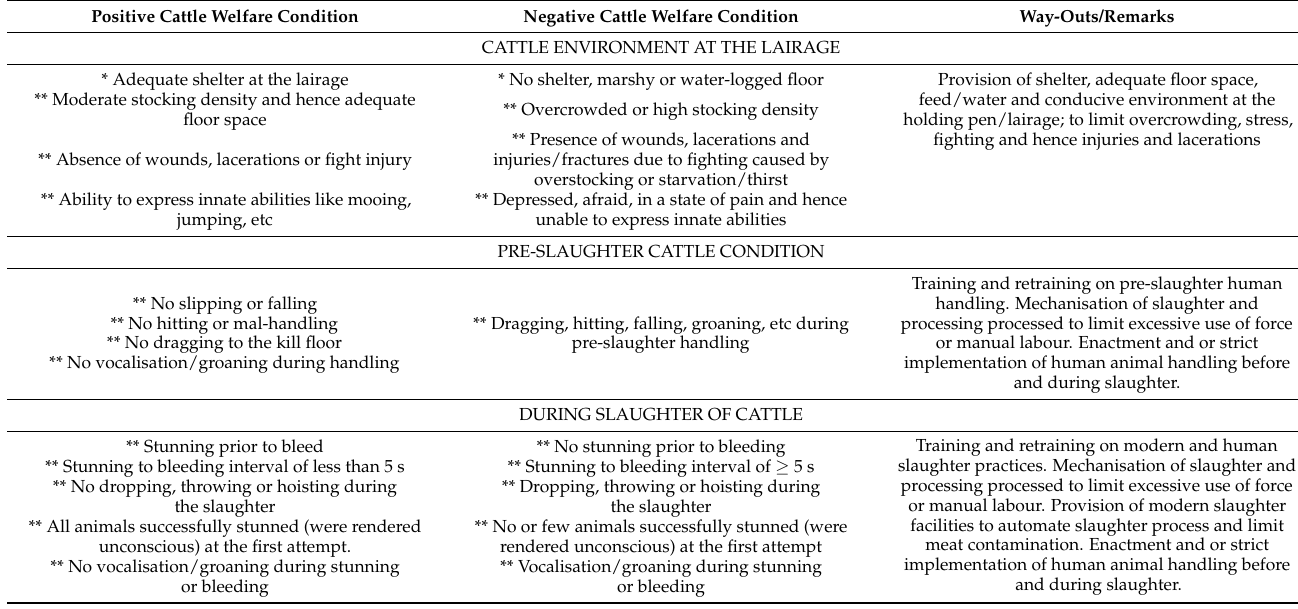
Figure 3. A schematic flow of assessment/decision-making protocol of slaughterhouse conditions/welfare. Table 1. Positive and negative cattle welfare conditions and corresponding way-outs, from environment conditions at the lairage, up to the actual slaughter